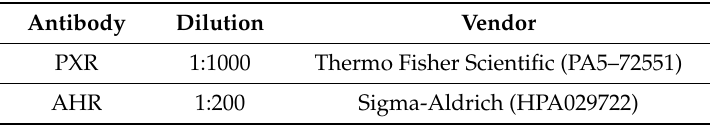
Table 4. List of antibodies and conditions used in tissue microarray (TMA) analysis. AHR: aryl hydrocarbon receptor, PXR: pregnane X